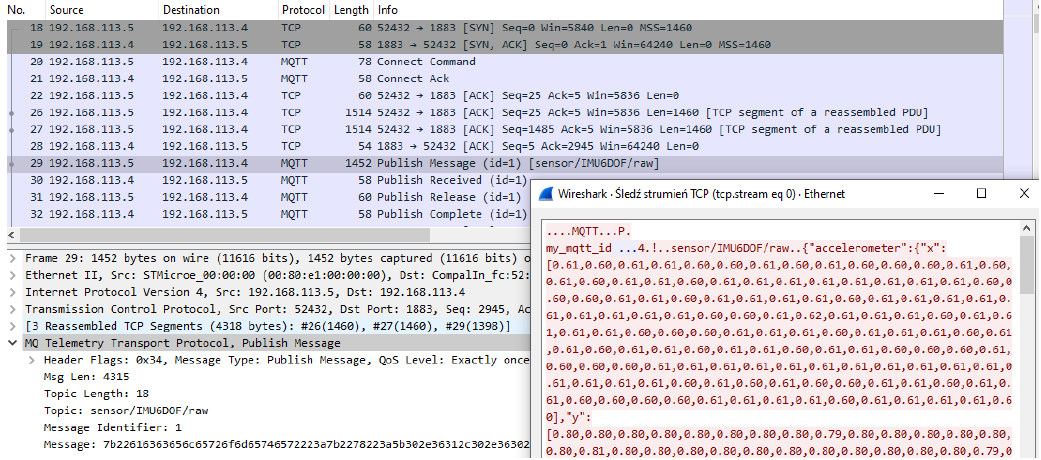
Figure 8. Captured MQTT v3.1 packets captured with TCP handshake for microcontroller MQTT client write sensor data to the topic sensor/IMU6DOF/raw as stream processing (micro batch) for